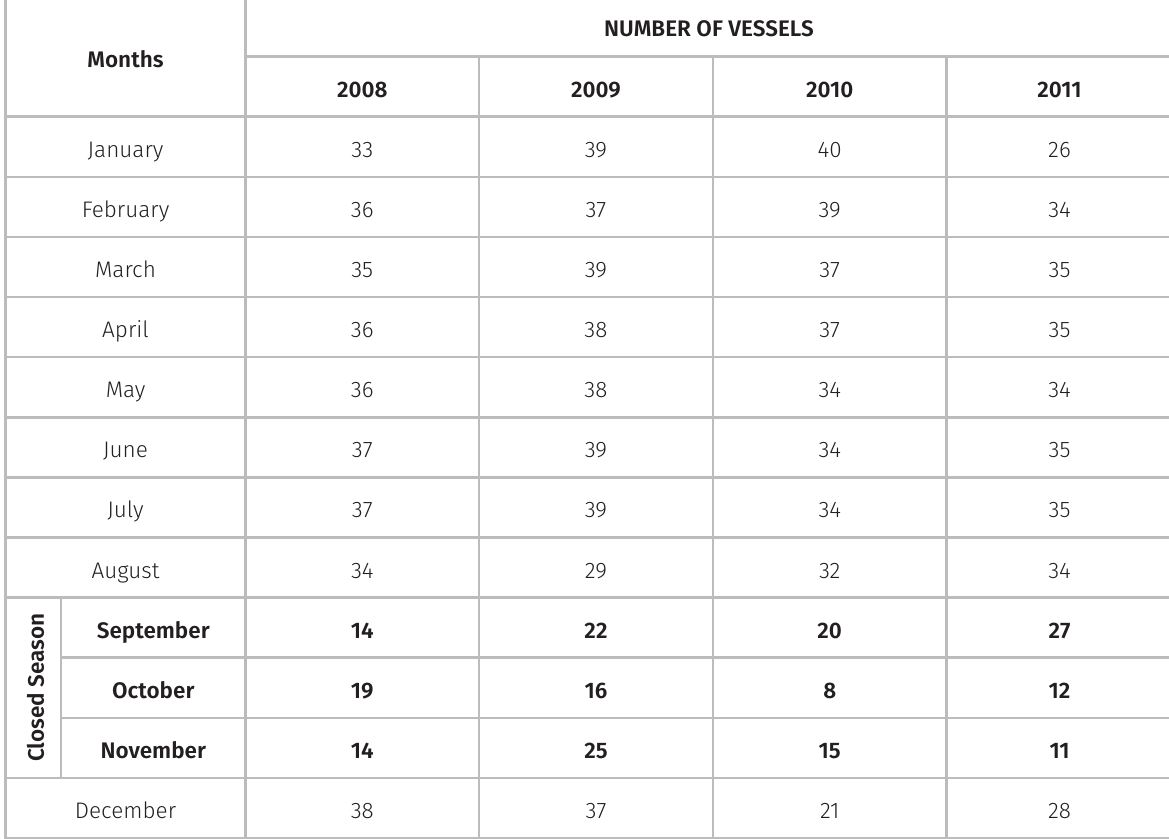
Table II. Number of vessels tracked by PREPS between 2008 and